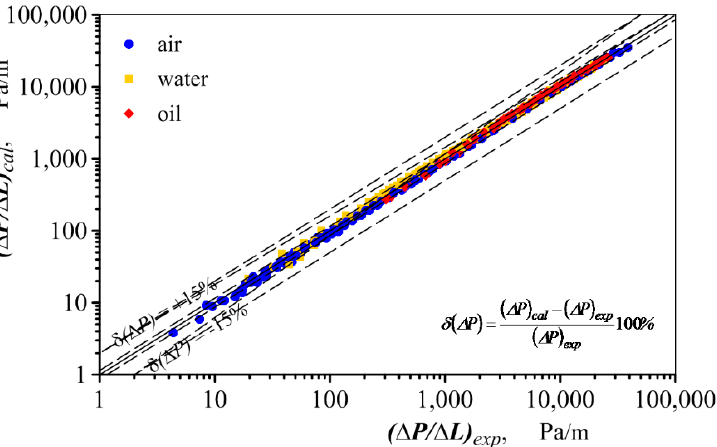
Figure 14. Comparison between the measured pressure drops in the single-phase flow and pressure drops calculated from Equations (7) and (8).